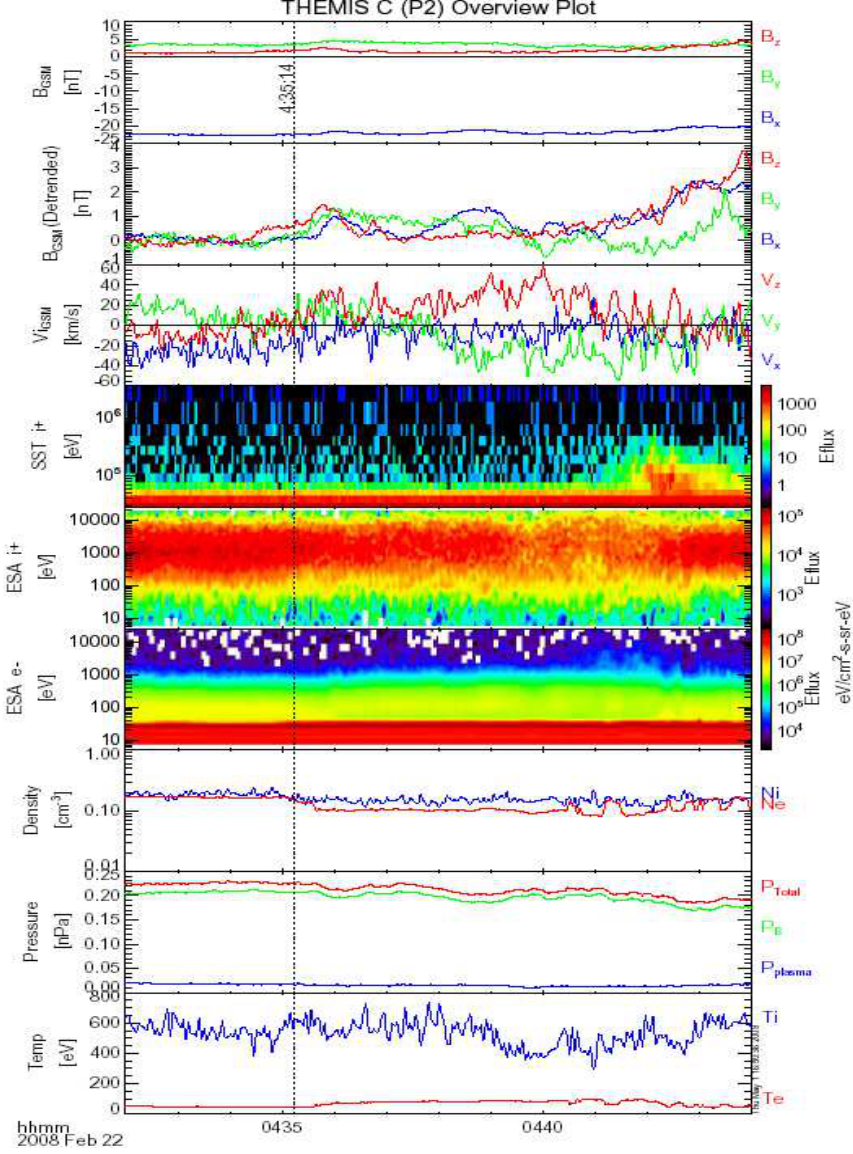
Fig. 5. Observations of THC on 22 February 2008 around